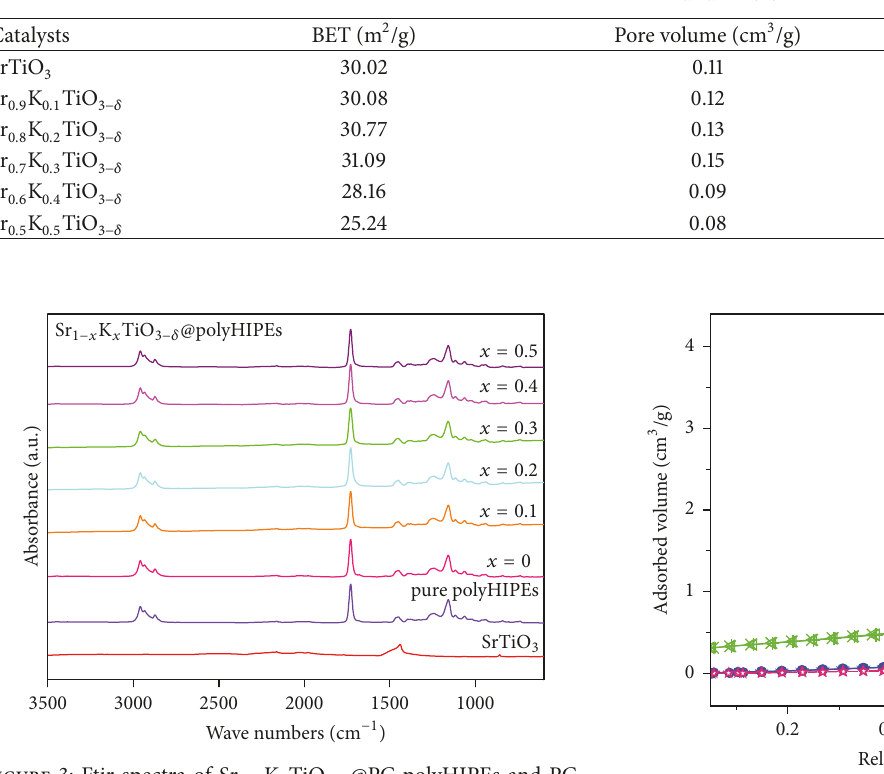
Table 1: Specific surface areas of Sr 1−𝑥 K 𝑥 TiO 3−𝛿 samples.